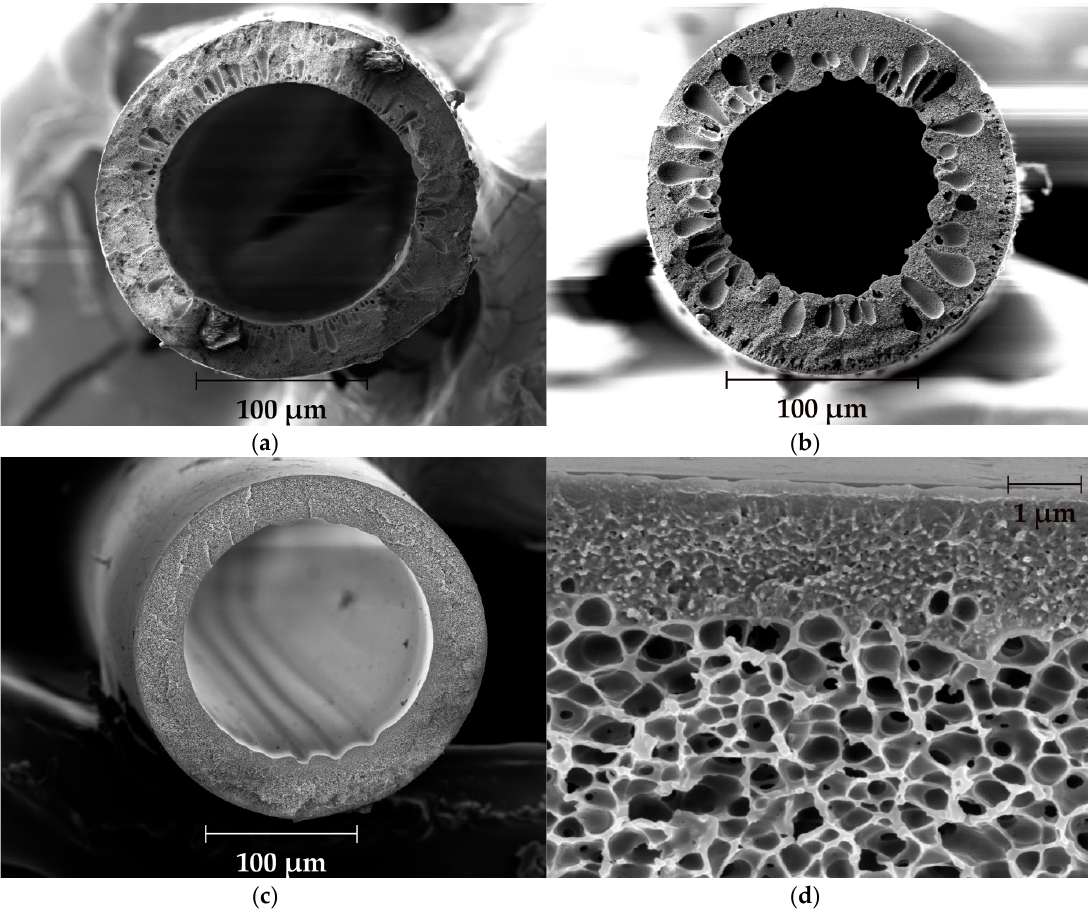
Figure 4. SEM micrographs of hollow fiber: ( a ) Sample #1, cross-section; ( b ) Sample #2, cross-section; ( c ) Sample #5, cross-section; ( d ) Sample #5, cross-section with the zoom of the selective layer.